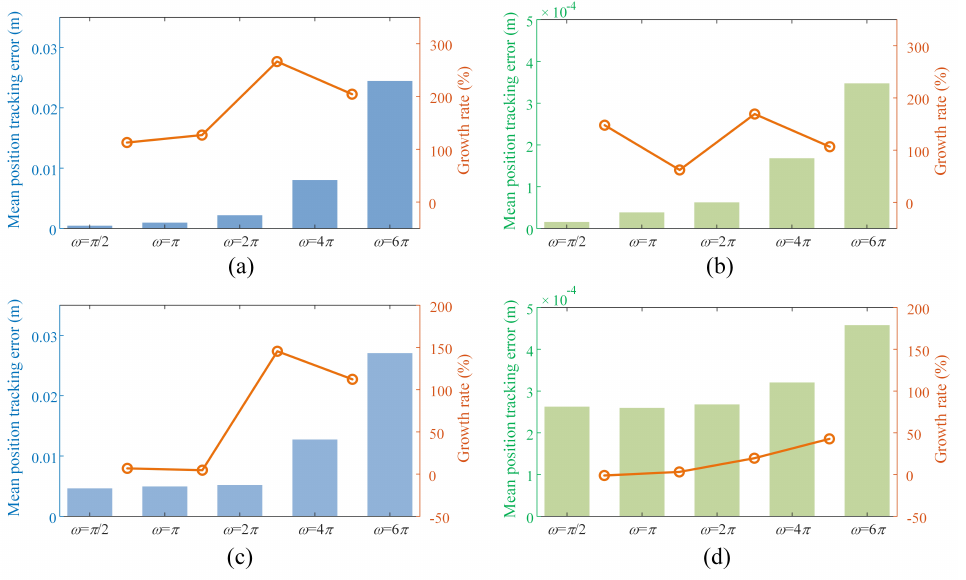
Figure 14. Mean position tracking error and error growth rate of two model-based controllers tracking signals with different speeds: ( a ) the dynamic feedforward controller in case 1, ( b ) the proposed controller in case 1, ( c ) the dynamic feedforward controller in case 2, and ( d ) the proposed controller in case